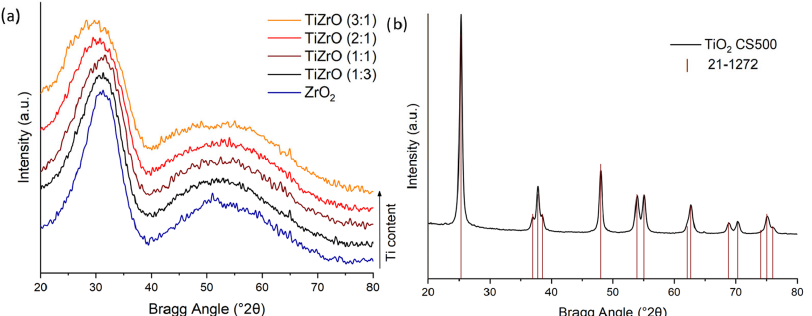
Figure 3. ( a ) Diffractograms obtained from XRD analysis of the mixed oxides Ti/Zr/O (3:1), Ti/Zr/O (2:1), Ti/Zr/O (1:1), Ti/Zr/O (1:3) and ZrO 2 ; ( b ) diffractograms obtained from XRD analysis of the mixed oxide TiO 2 .